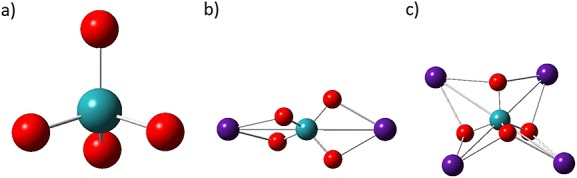
The model structures of (a) RuO42−, (b) Cs2RuO4, and (c) Cs4RuO42+.